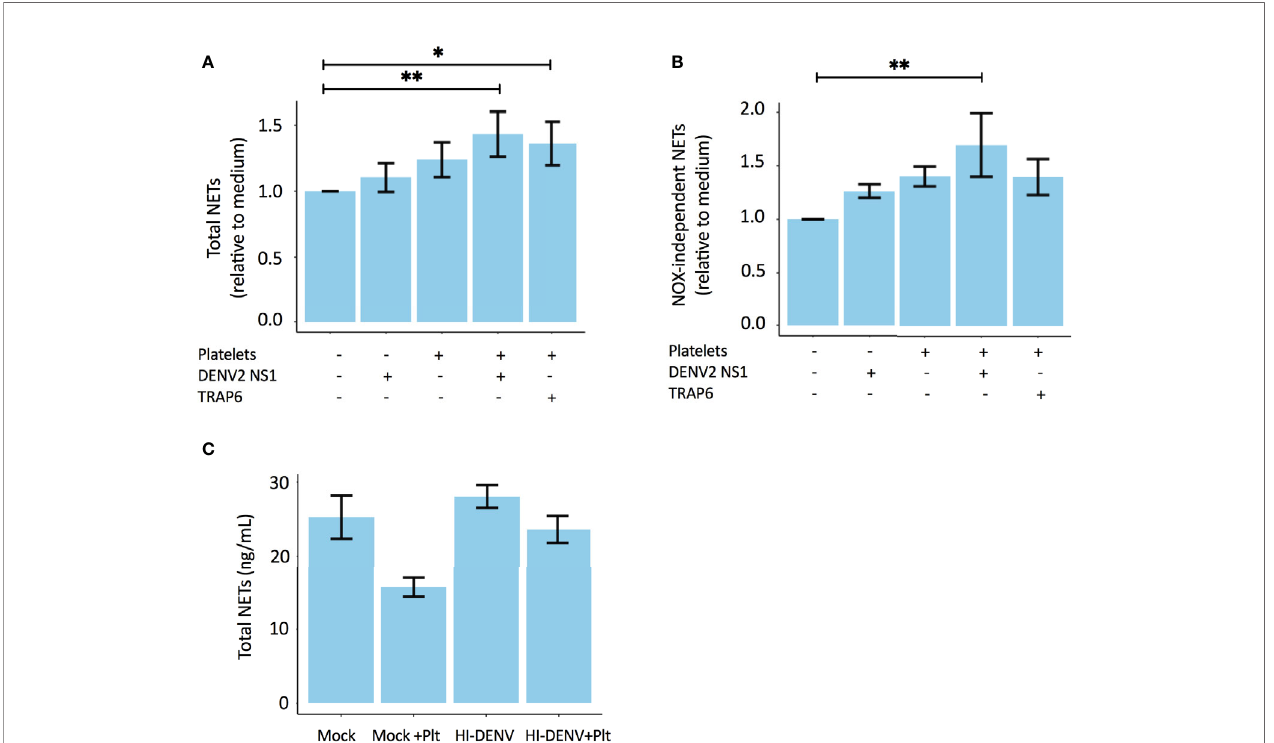
FIGURE 3 | Platelets stimulate NOX-independent NET formation in a DENV NS1-dependent manner. Polymorphonuclear neutrophils (PMNs) of healthy volunteers were co-incubated with autologous platelets in the presence or absence of 10 µg/mL DENV2 NS1 or 156 m M platelet agonist TRAP-6. Experiments were performed in triplicate with 2 donors for each condition. Depicted are the relative values to medium (unstimulated samples) for (A) Total NETs and (B) NOX-independent NETs. (C) Heat-inactivated DENV2 does not induce NET formation. PMNs isolated from three healthy donors were incubated with 0.5x10 7 TCID/mL heat-inactivated DENV2 or medium control (mock) in the presence or absence of autologus washed platelets (Plt). Depicted is the total NET formation (ng/mL). Data are presented as mean with standard error mean (SEM) and analyzed using repeated measure a one-way ANOVA and Bonferroni ’ s multiple comparisons test; * p < 0.05, **p < 0.01 . TCID, Tissue culture infectious